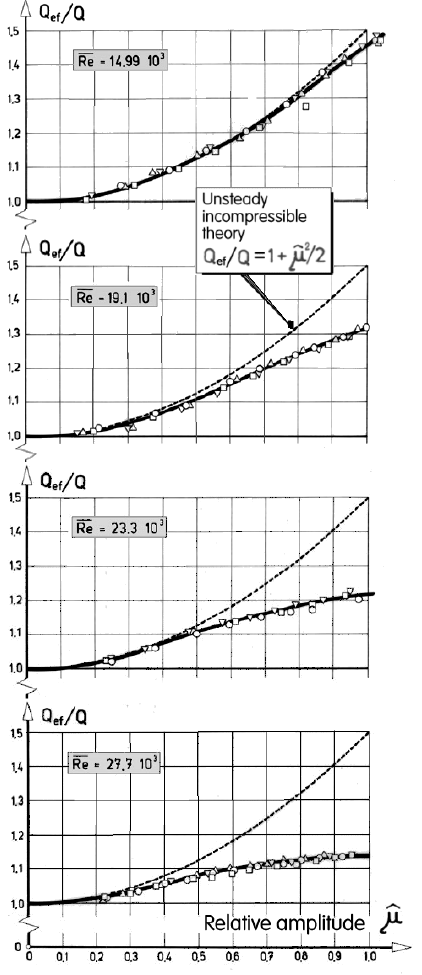
Fig. 16. Examples of time-mean pressure drops across the nozzle measured by the author. The values are smaller than the theory presented in Fig. 15. This pressure-decreasing effect was stronger with increased magnitude of the DC flow component (in the diagrams characterised by the time-mean Reynolds number — although later analysis has shown that this is not a Re effect).